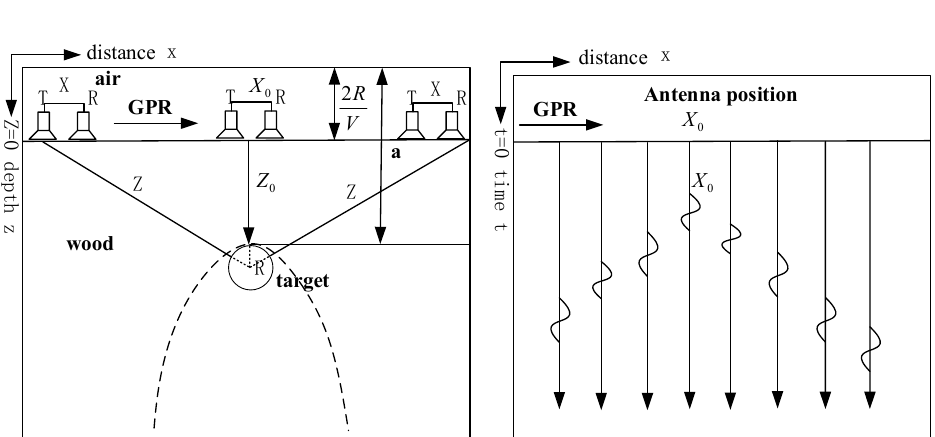
Figure 1. The GPR geometric model and the reflection of the target.